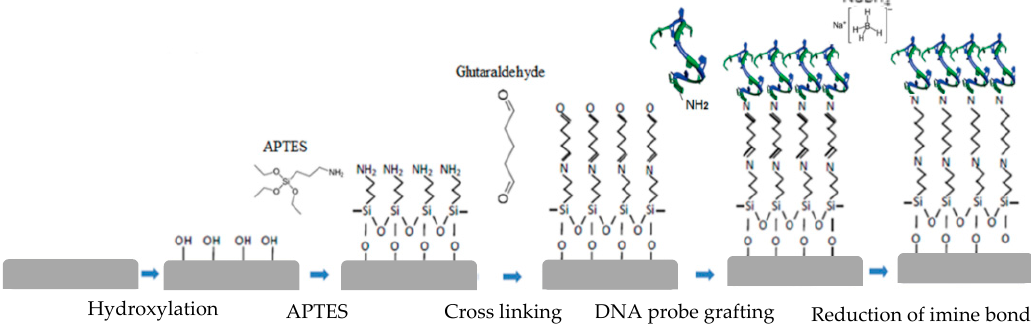
Figure A1. APTES-based functionalization protocol for covalent DNA probe grafting.